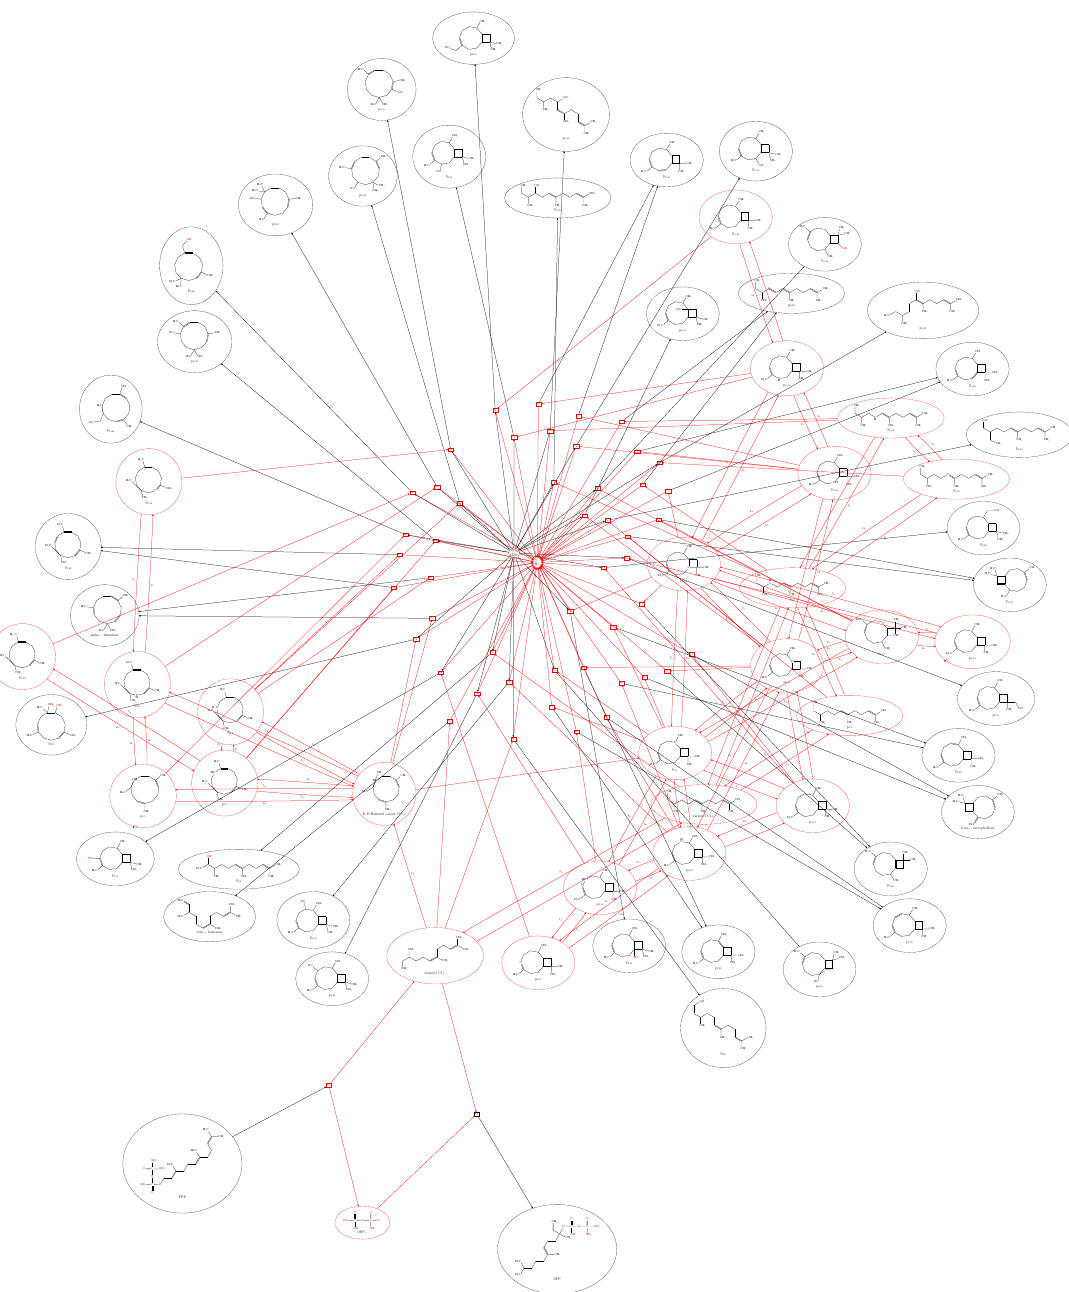
Figure 3. The exploratory strategy yielded 55 predicted molecules: Stable, neutral molecules are outlined in black, while cations and anions are outlined in